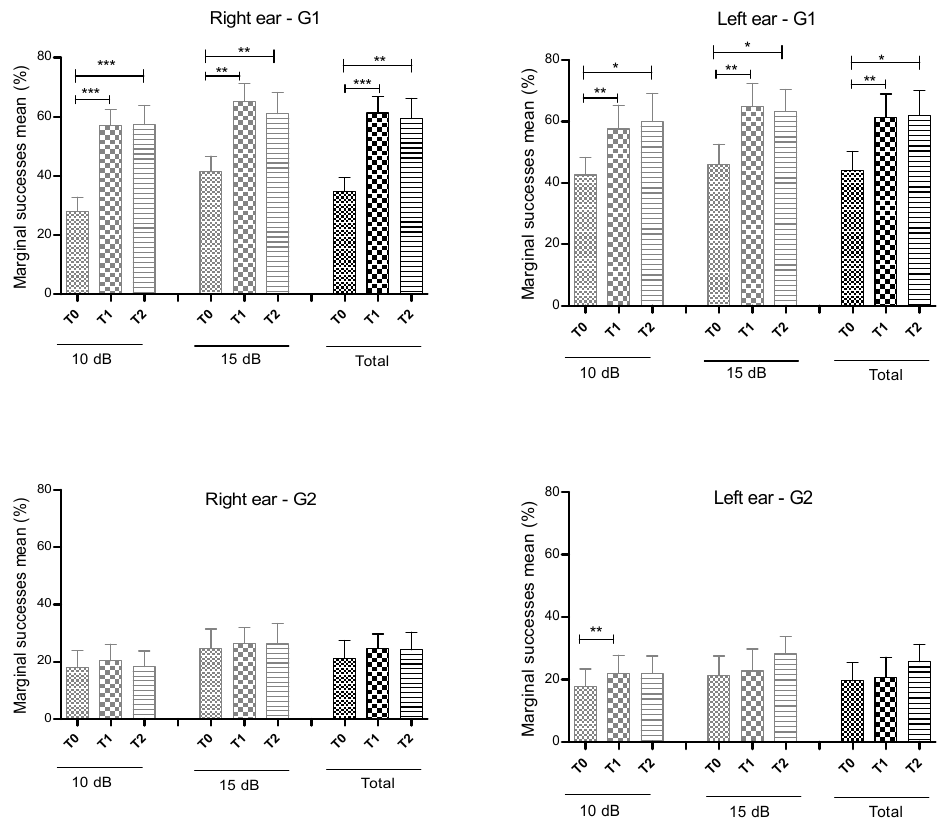
Figure 3. Representation of marginal successes mean obtained at T0, T1 and T2 for a signal to noise ratio of 10 dB, 15 dB and total in group 1 (G1—upper panel) and group 2 (G2—bottom panel) for the right ear (left row) and left ear (right row). * p < 0.05; ** p < 0.01; *** p < 0.001. Factorial analysis showed that training had a significant effect on success (F (2) = 22.221; p < 0.001), with an absence of significant effects either for the ear factor (F = 1.142; p = 0.327) and for the age factor (F = 0.359; p = 0.706). In other words, success was not influenced by the ear or by the age of